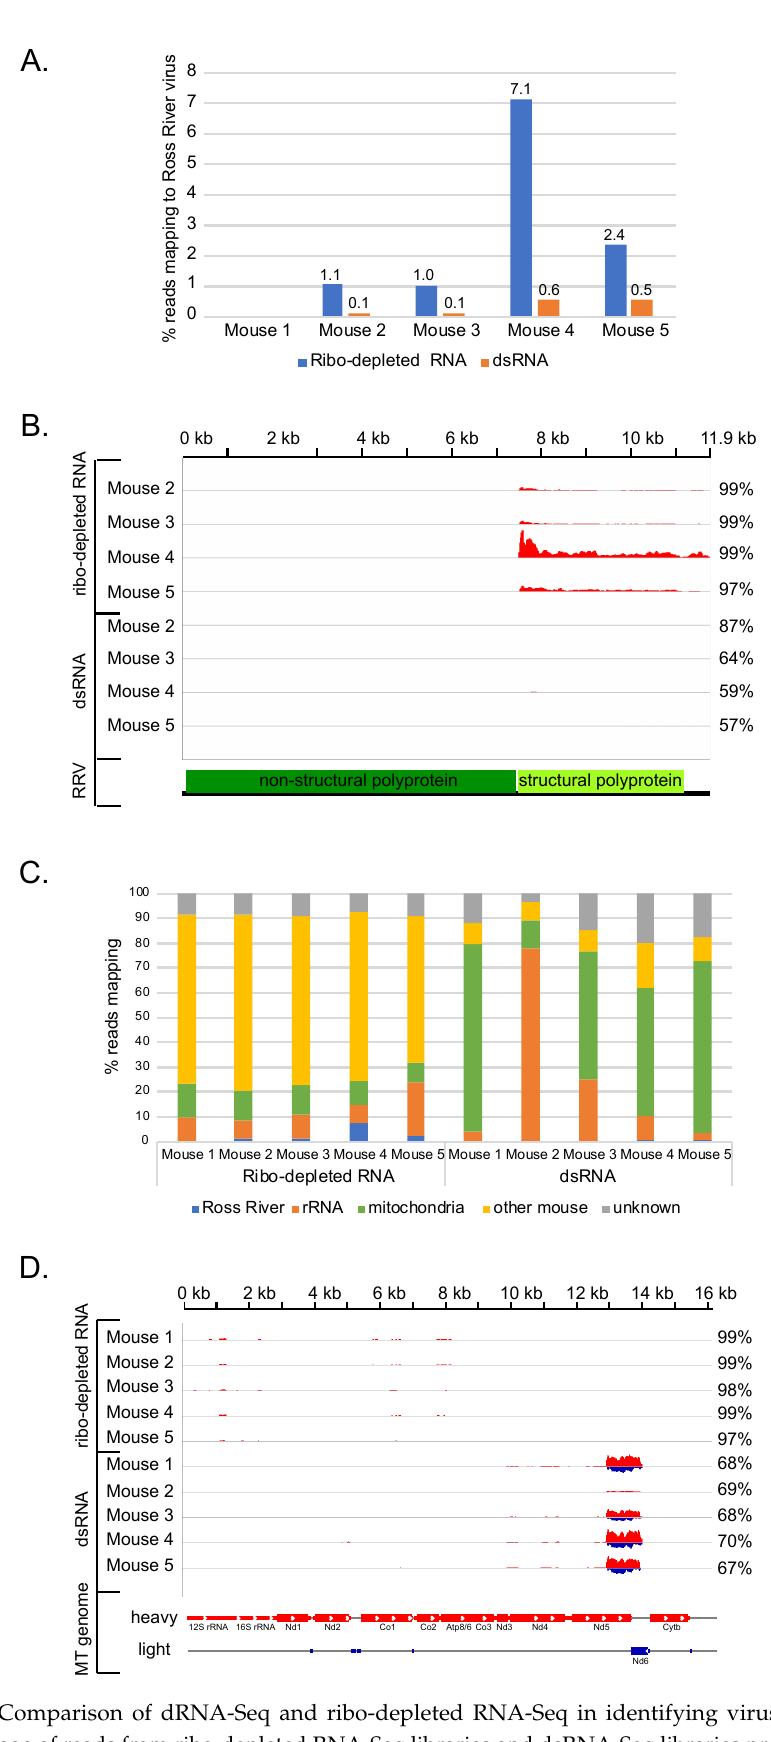
Figure 3. Comparison of dRNA-Seq and ribo-depleted RNA-Seq in identifying virus infections. ( A ) Percentage of reads from ribo-depleted RNA-Seq libraries and dsRNA-Seq libraries prepared